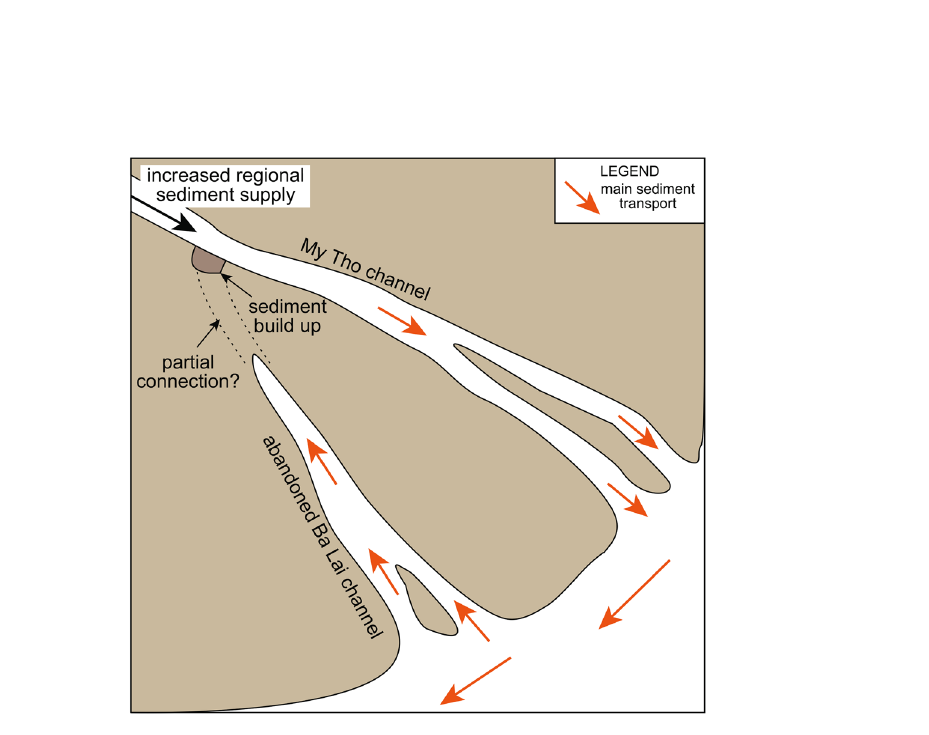
Figure 8. Schematic model showing the abandonment of the Ba Lai channel due to a sediment buildup and the infill with sediment from its